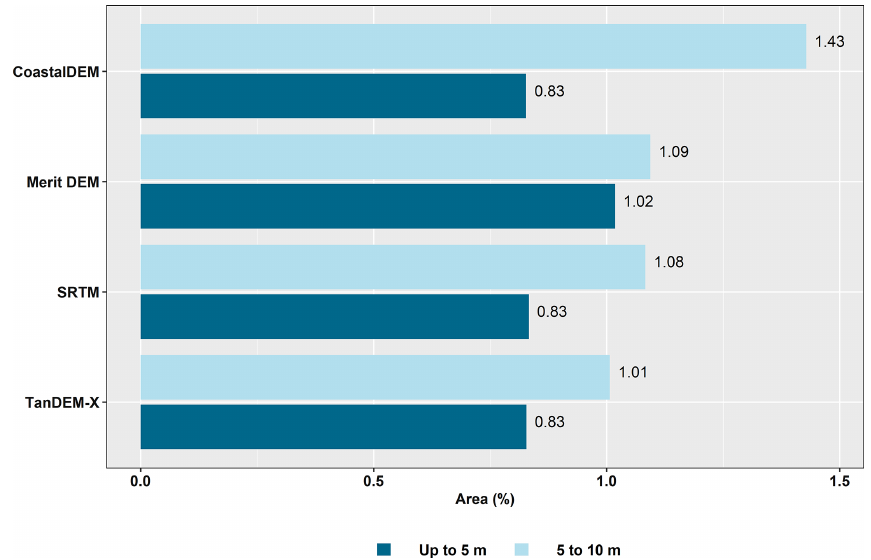
Figure 8. Percentage of total land area in the ≤ 5 and 5–10m LECZ, by different elevation